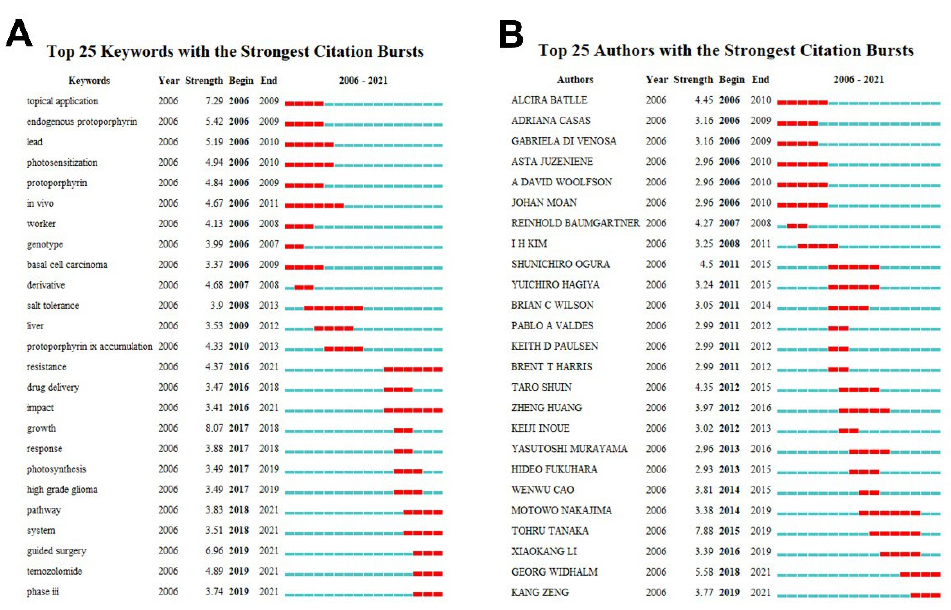
Figure 5. Hotspots and frontiers in 5-ALA research field. ( A ) The top-25 keywords with strongest citation burst detected by CiteSpace. ( B ) The top-25 authors with strongest citation burst detected by CiteSpace.